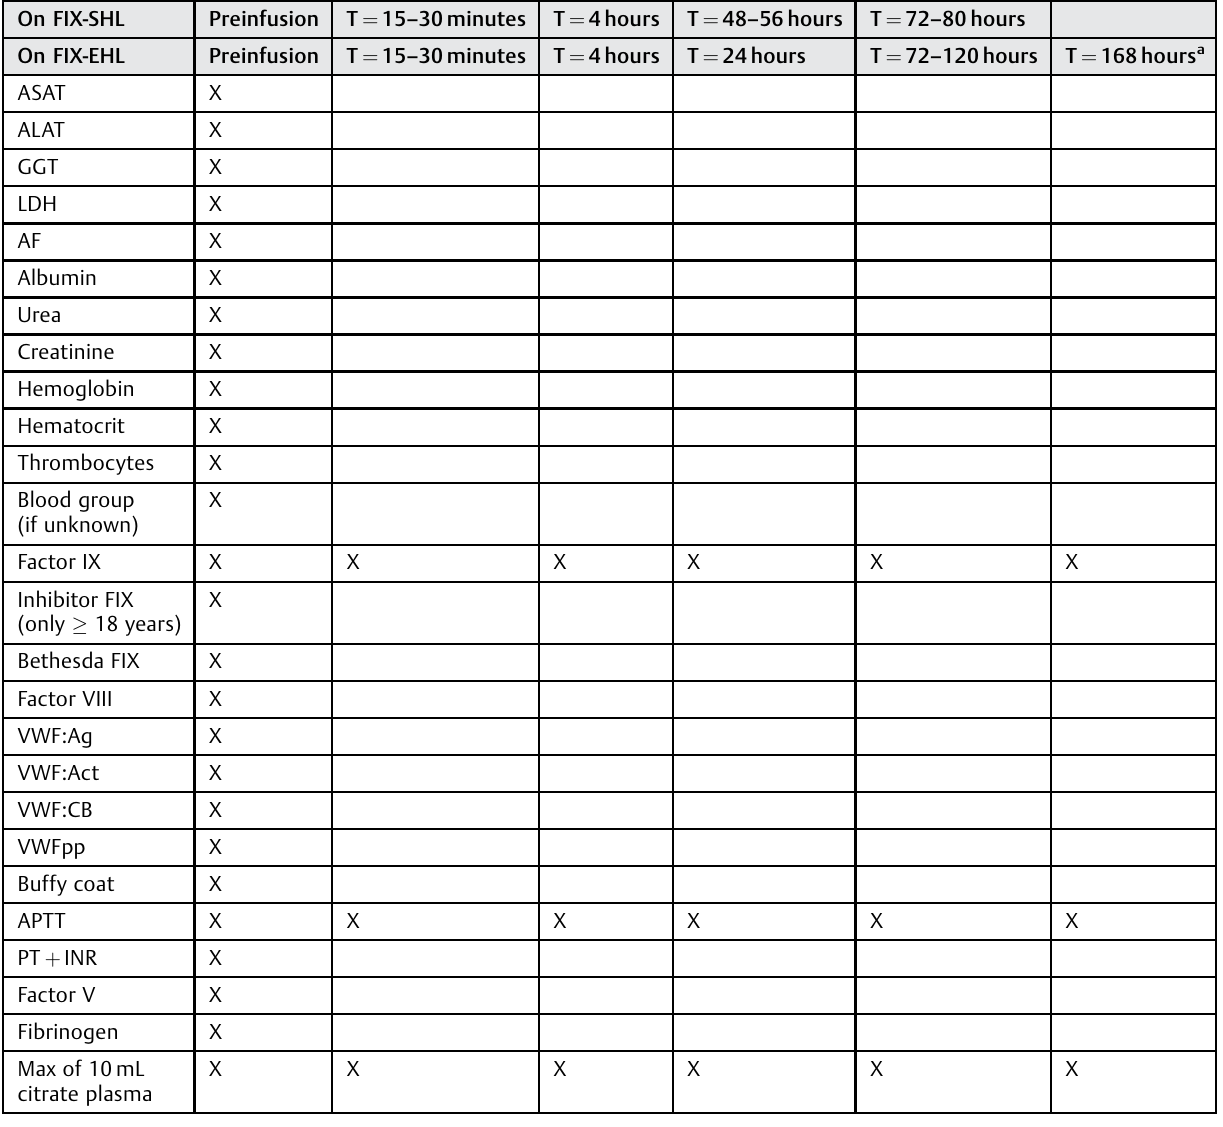
Table 2 Laboratory tests during individual PK pro fi ling for patients with hemophilia B On